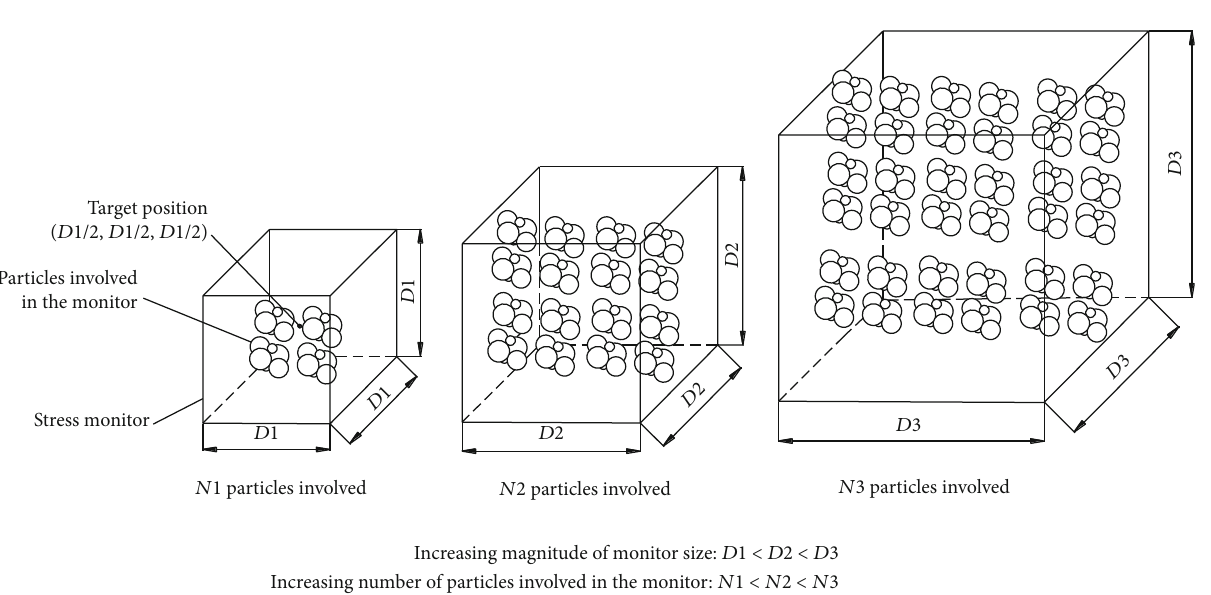
Figure 8: Experiments design for selecting suitable size for stress